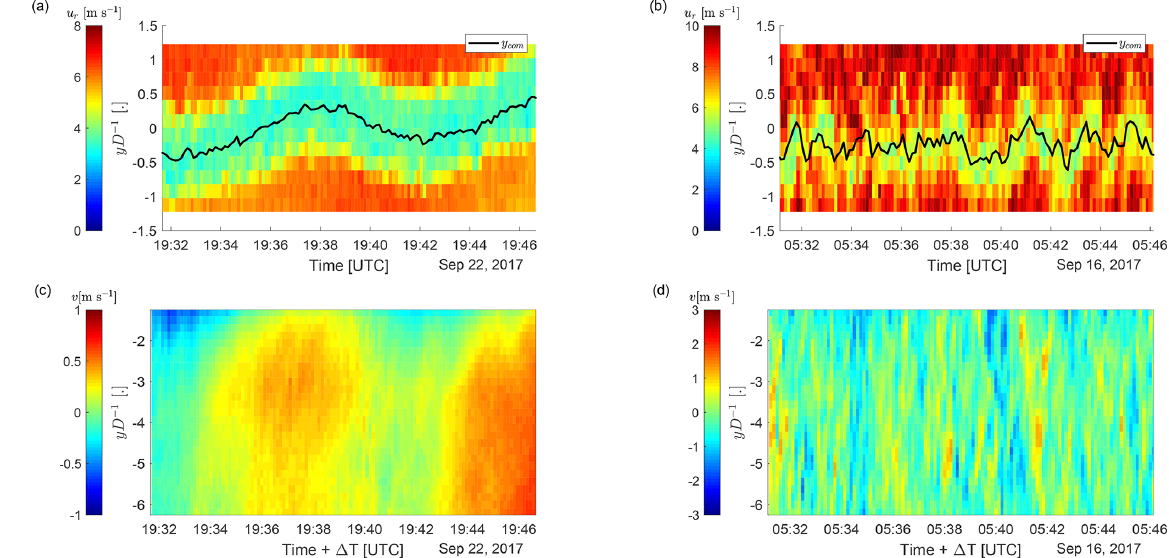
Figure 6. The time series of the line-of-sight velocity profiles at xD − 1 = 6 from the wake-scanning Doppler lidar (a, b) and the time series of the lateral velocity along the laser beam of the laterally staring Doppler lidar (c, d) . The example case in the left column (a, c) was chosen for its visually clear relationship between lateral velocity and wake centre position. The example case in the right column (b, d) illustrates the absence of a correlation between lateral velocity and wake centre position even though wake meandering is visible. The lateral velocity for (d) to account for a time delay arising due to the downstream advection. was time shifted with (cid:49)T = 6 Du − 1 for (c) and (cid:49)T = 6 Du − 1 hub adv